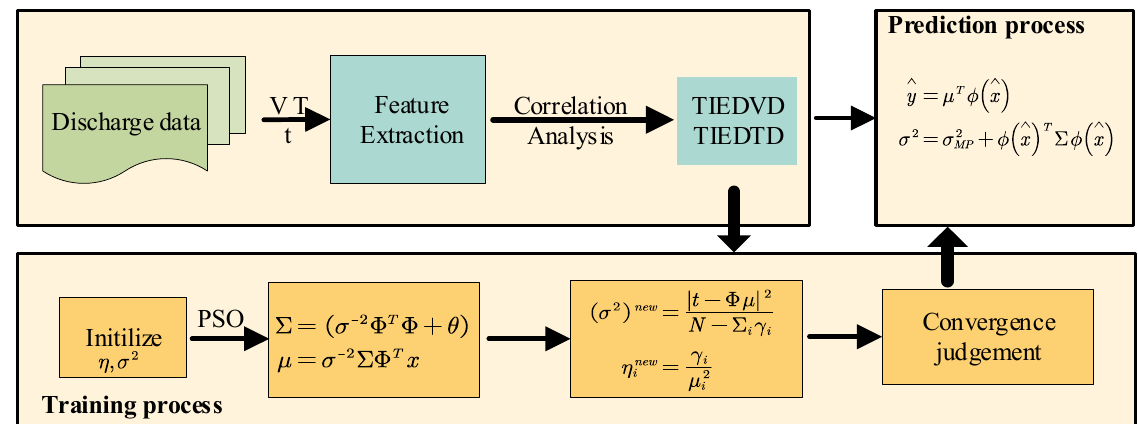
Figure 5. The procedure of the MKRVM.